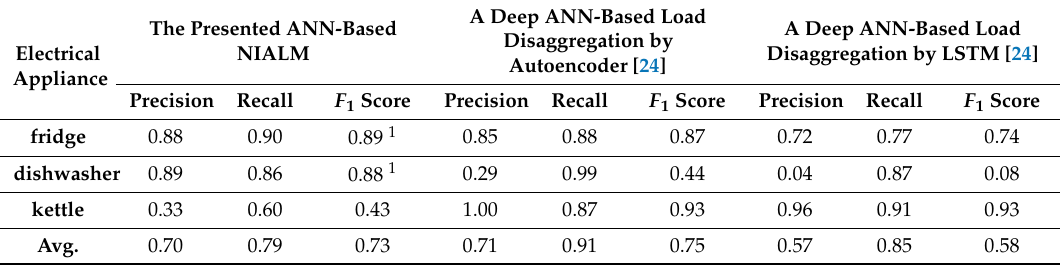
Table 10. Comparison among the autoencoder, the LSTM and the presented feed-forward, multilayer ANN for load